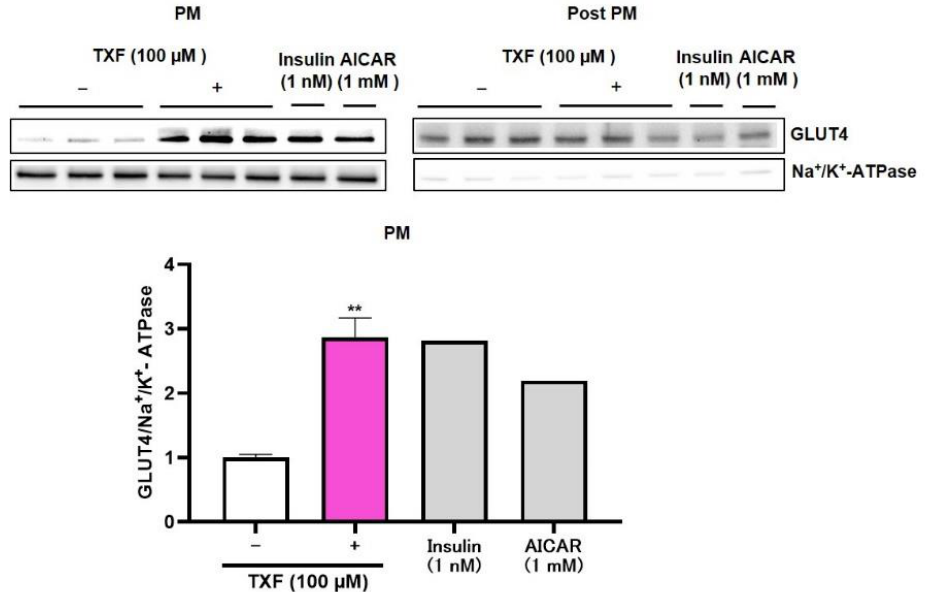
Figure 3. Effect of taxifolin on translocation of GLUT4 to plasma membrane after 30 min exposure of TXF (0 and 100 µM) to L6 myotubes. Each value represents the mean ± SEM for 3 dishes (60 mm in diameter). Insulin ( n = 1) and AICAR ( n = 1) were used as positive controls and excluded from statistical analyses. ** Statistically significant from no TXF treatment at p < 0.01 by the two-tailed Student’s t -test. Table 1. Initial and final body weights, body weight gain, and food intake for four weeks in T2D model KK-A y /Ta